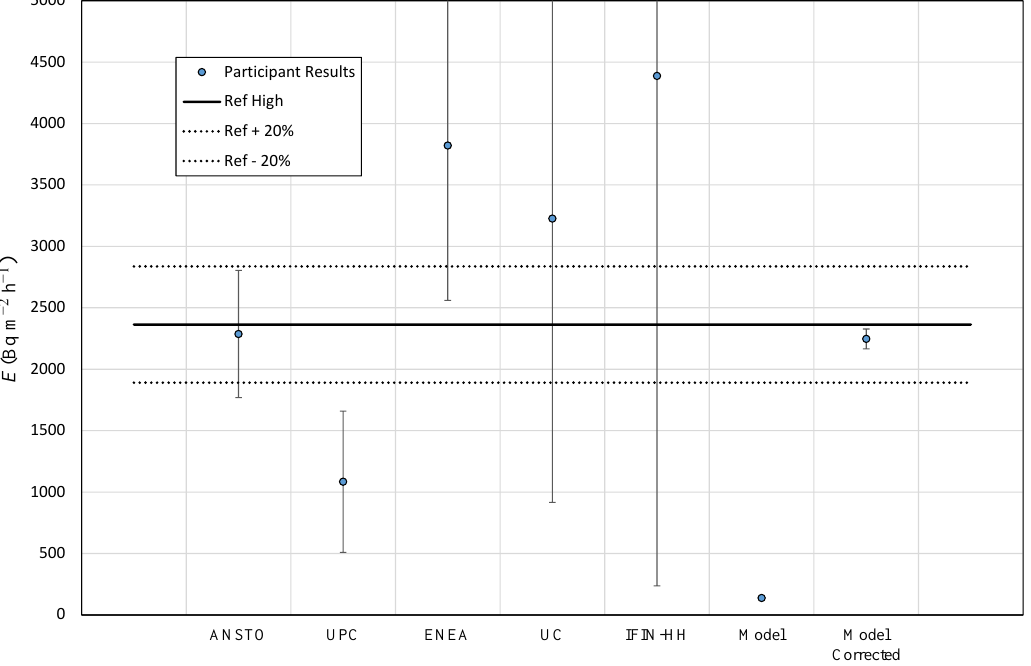
Figure 13. Participants results: average and reference value for the high radon flux area campaign.